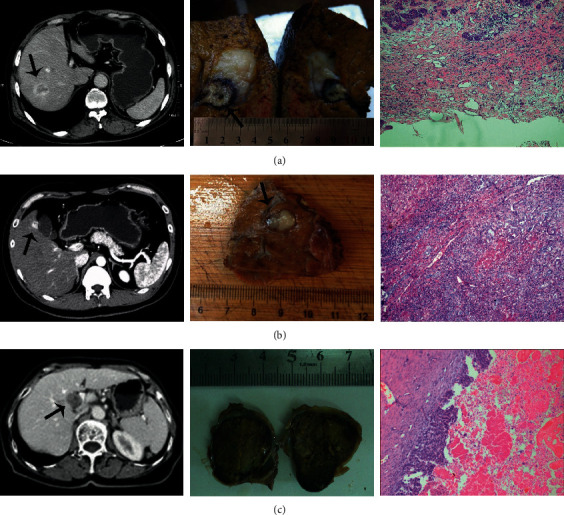
Three cases of ablation failure experienced before 2012 when preoperative biopsy was not routinely performed. (a) A 64-year-old male with sclerosing hepatocellular carcinoma who underwent surgical resection after ablation failure. The initial ablation site was indicated, showing the poor ablation scope and efficacy. The subsequent immunohistostaining revealed a severe fibrous component (∼80% of the tumor tissue) causing unexpected hardness, a high level of heat resistance, and poor heat conduction. (b) A 37-year-old male patient with bile duct adenocarcinoma who underwent surgical resection. The immunohistostaining indicated mild fibrosis (∼40%). The failure cause was the displacement of the rubbery tumor during puncture and a high level of heat resistance. (c) A 72-year-old female patient with intrahepatic cholangiocarcinoma. Typical cystic changes were found in histological sections. The rigid tumor capsule composed of a fibrous component and necrotic tumor tissue completely prevented puncture.